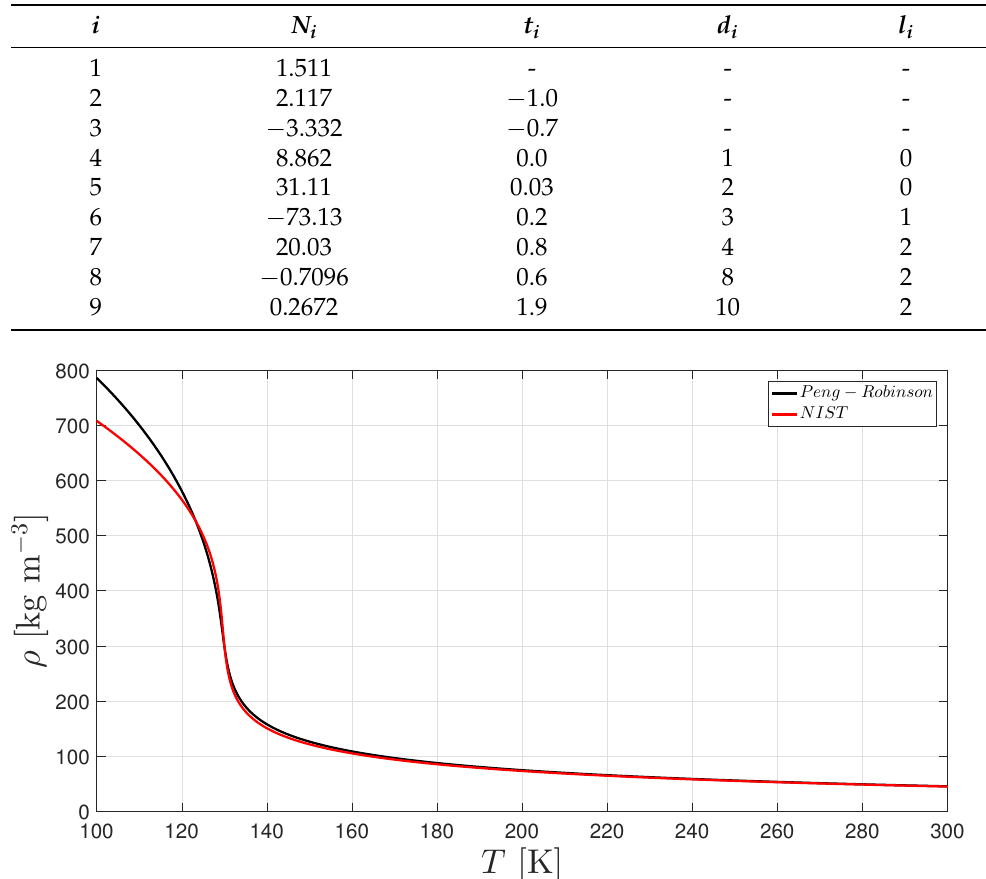
Figure 3. Validation of the Peng-Robinson EoS [54] with respect to the NIST